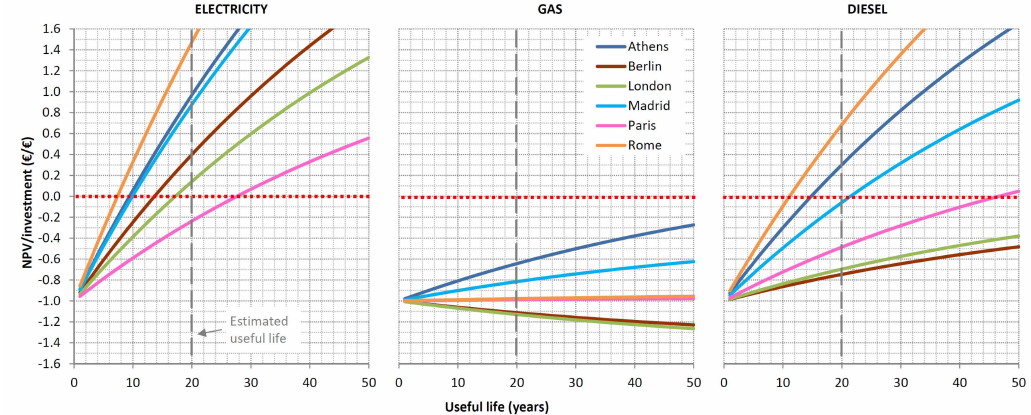
Figure 9. Variation in the net present value (NPV)/investment ratio due to changes in the useful life of the